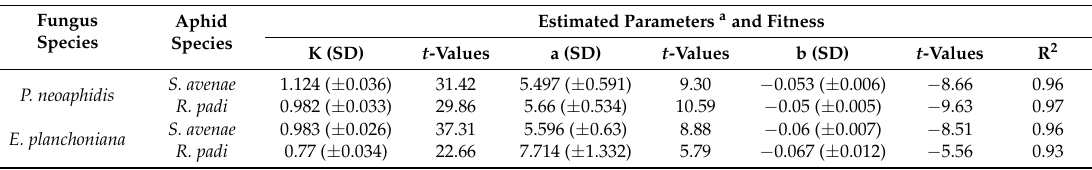
Table 4. Estimation of the non-linear least-square regression model of the mortality of Sitobion avenae and Rhopalosiphum padi to fungal